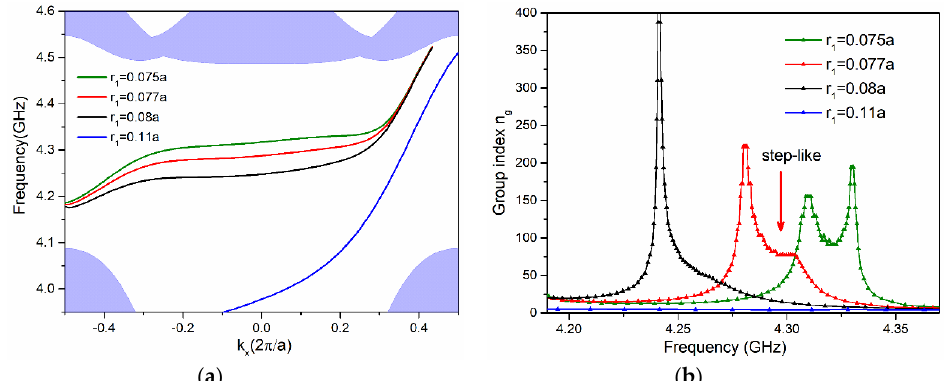
Figure 3. ( a ) Dispersion curves of the edge modes for different 𝑟 1 with an externally applied magnetic field along the + z direction. The shadow region denotes the extended modes of a perfect MOPC; ( b ) Group indices as a function of the frequencies, the relevant step-like behavior is indicated.